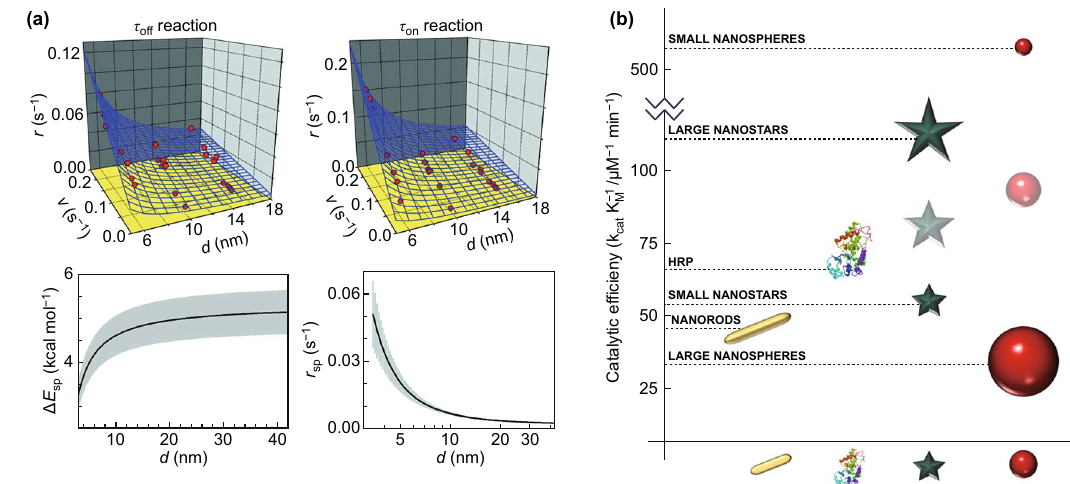
Fig. 3 Comparison of the catalytic efficiency of AuNPs with different sizes and shapes. a Dynamics of the reduction reaction of resazurin to resorufin catalysed by different‑sized AuNPs. It shows how the NP size affects the surface restructuring rate dependence on the rate of turnovers for the catalytic product formation (top left) and for the product dissociation (top right), and the NP size dependence of the activation energy (bottom left) and of the rate of spontaneous dynamic surface restructuring (bottom right) [98]. Copyright American Chemical Society 2010. b Comparison of the catalytic efficiency for the peroxidase‑like activity of different‑shaped and different‑sized AuNPs. HRP, their biological coun‑ terpart, is also included in the